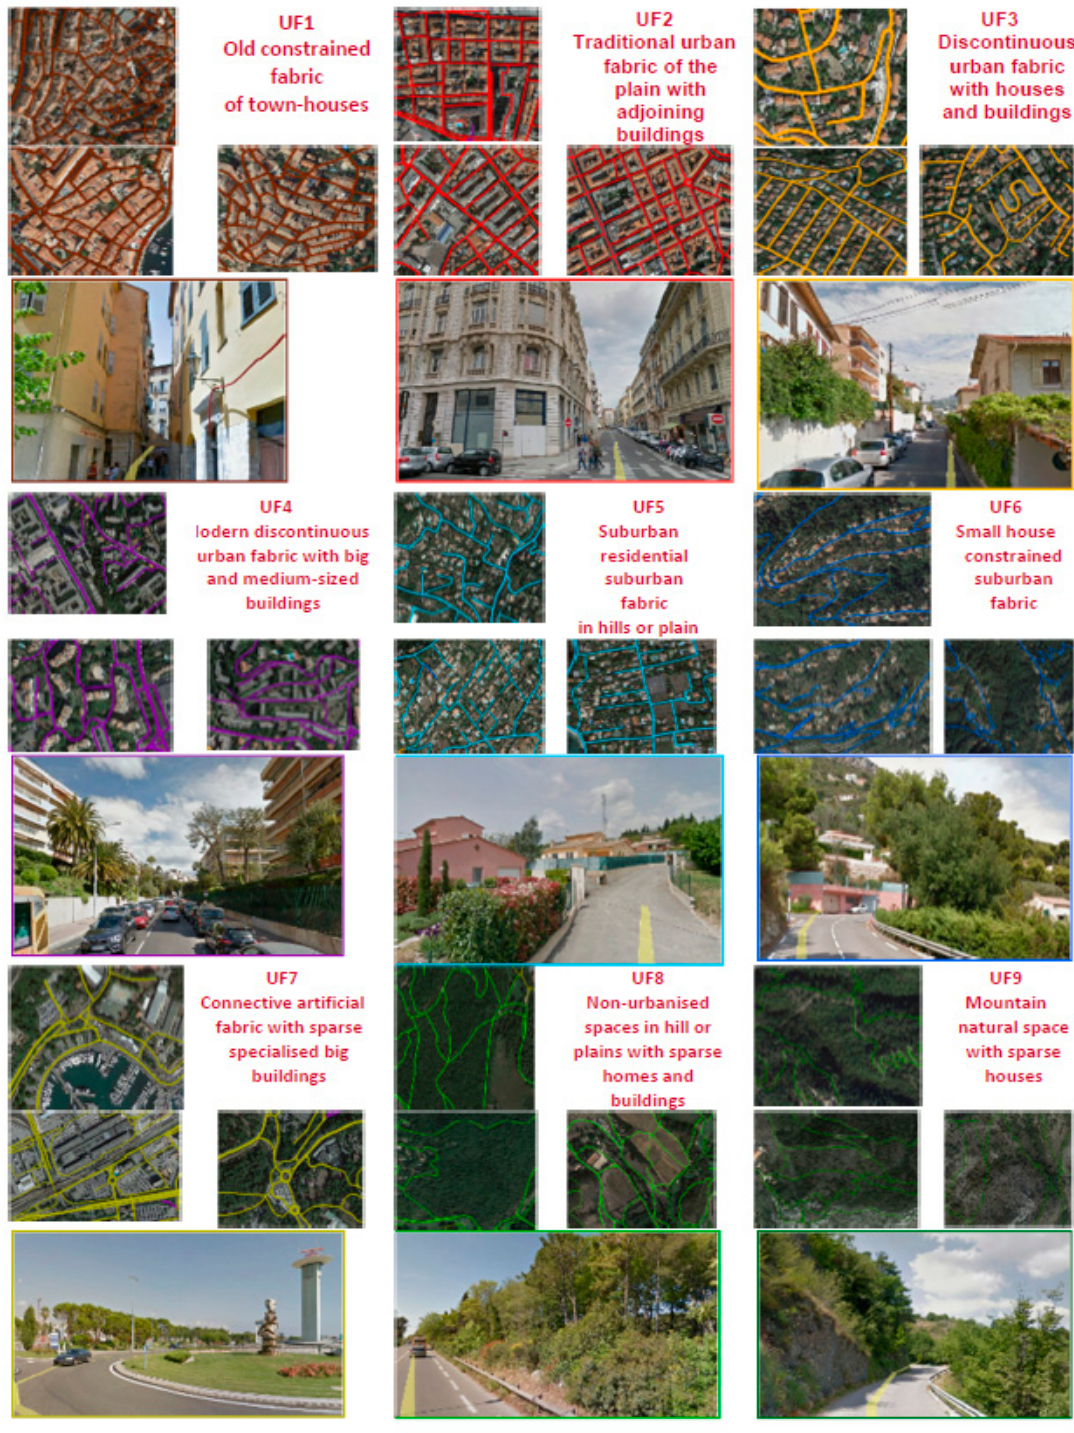
Figure A2. Aerial and street view images of the nine urban fabrics (UFs) of the French Riviera as defined by the MFA protocol (source: Google Map and Google Street view 2017, [56,57,89]).